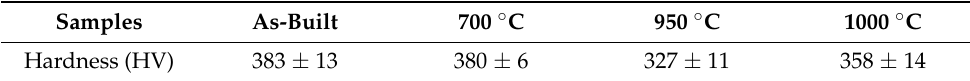
Figure 6. Hardness profiles of the as-built and heat-treated samples. Table 1. Average hardness of the as-built and heat-treated samples.